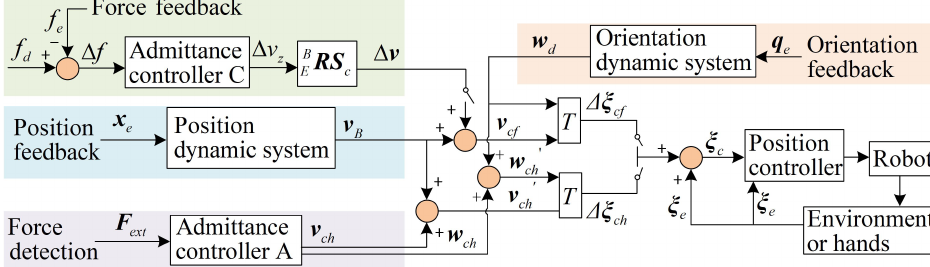
Figure 4. Motion controllers for the contact task execution. The admittance controller C adjusts z-direction velocity to obtain the desired force in the contact space or achieve robot return contact space fast and safely after human interaction. Admittance controller A modulates the both the linear and angular velocity to realize robot movement along human